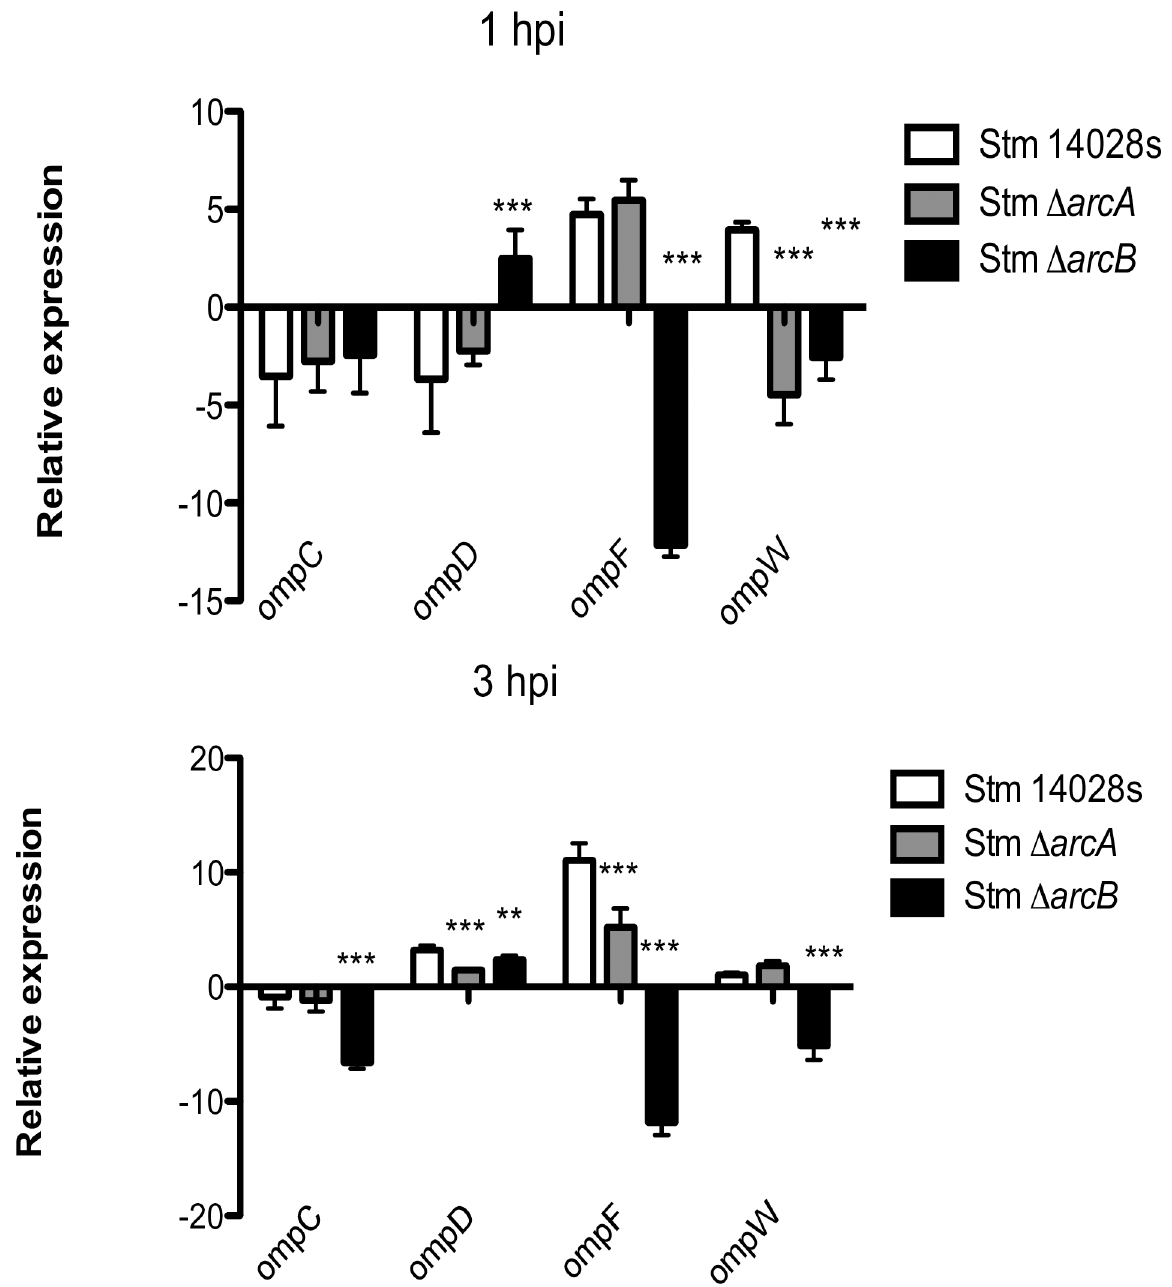
Fig 5. Relative expression of porin genes ( ompC , ompD , ompF and ompW ) in S . Typhimurium Δ arcA and Δ arcB strains inside bone- marrow-derived murine neutrophils. Δ arcA and Δ arcB strains inside bone-marrow-derived murine neutrophils. (cid:3) P < 0 05; (cid:3)(cid:3) P < 0 01; (cid:3)(cid:3)(cid:3) P < 0 001. One-way ANOVA with the Bonferroni correction comparing mutant strains with a wild type strain separately at 1 and 3 h postinfection. Biological replicates n = 5, three technical replicates per